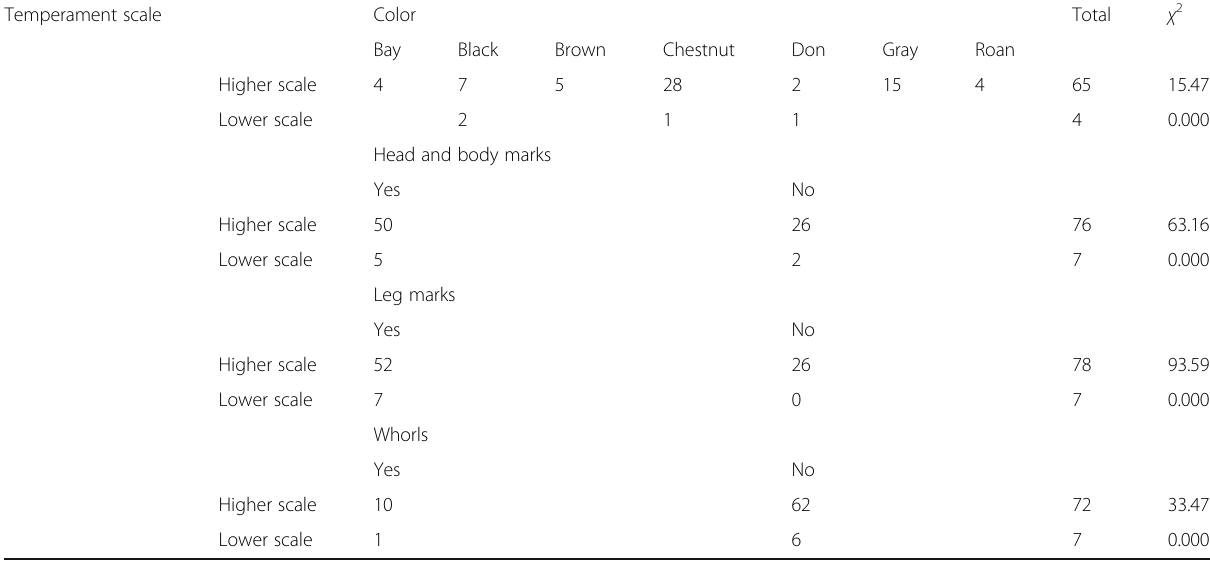
Table 3 Association between temperament scale and horse ’ s body characteristics Temperament